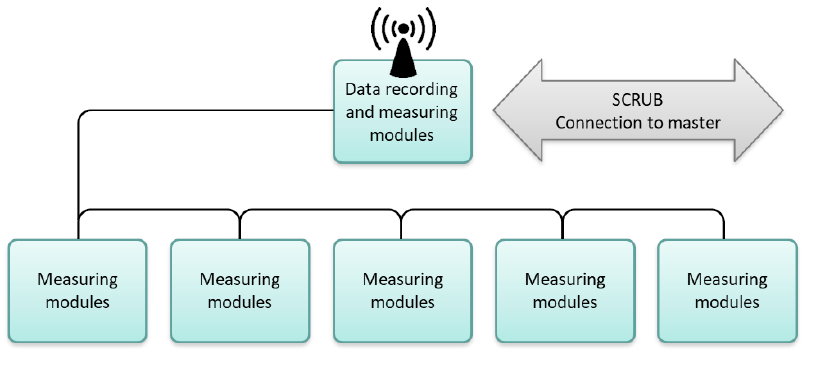
Figure 1. Structure of measuring system [10].